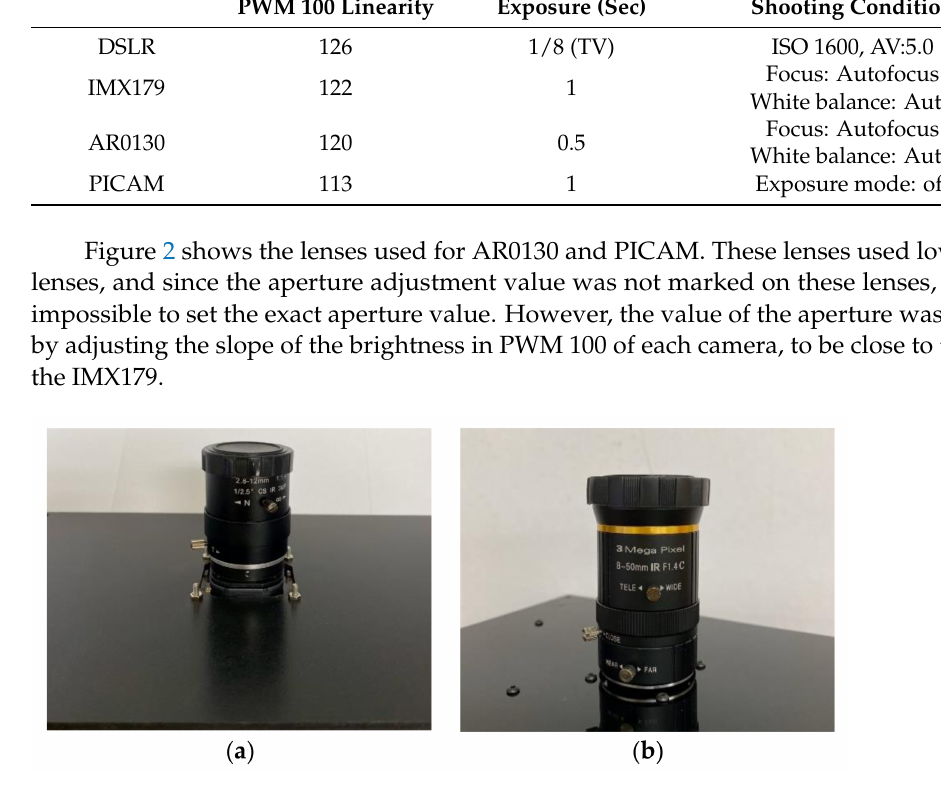
Figure 2. Lens aperture: ( a ) AR0130; ( b )